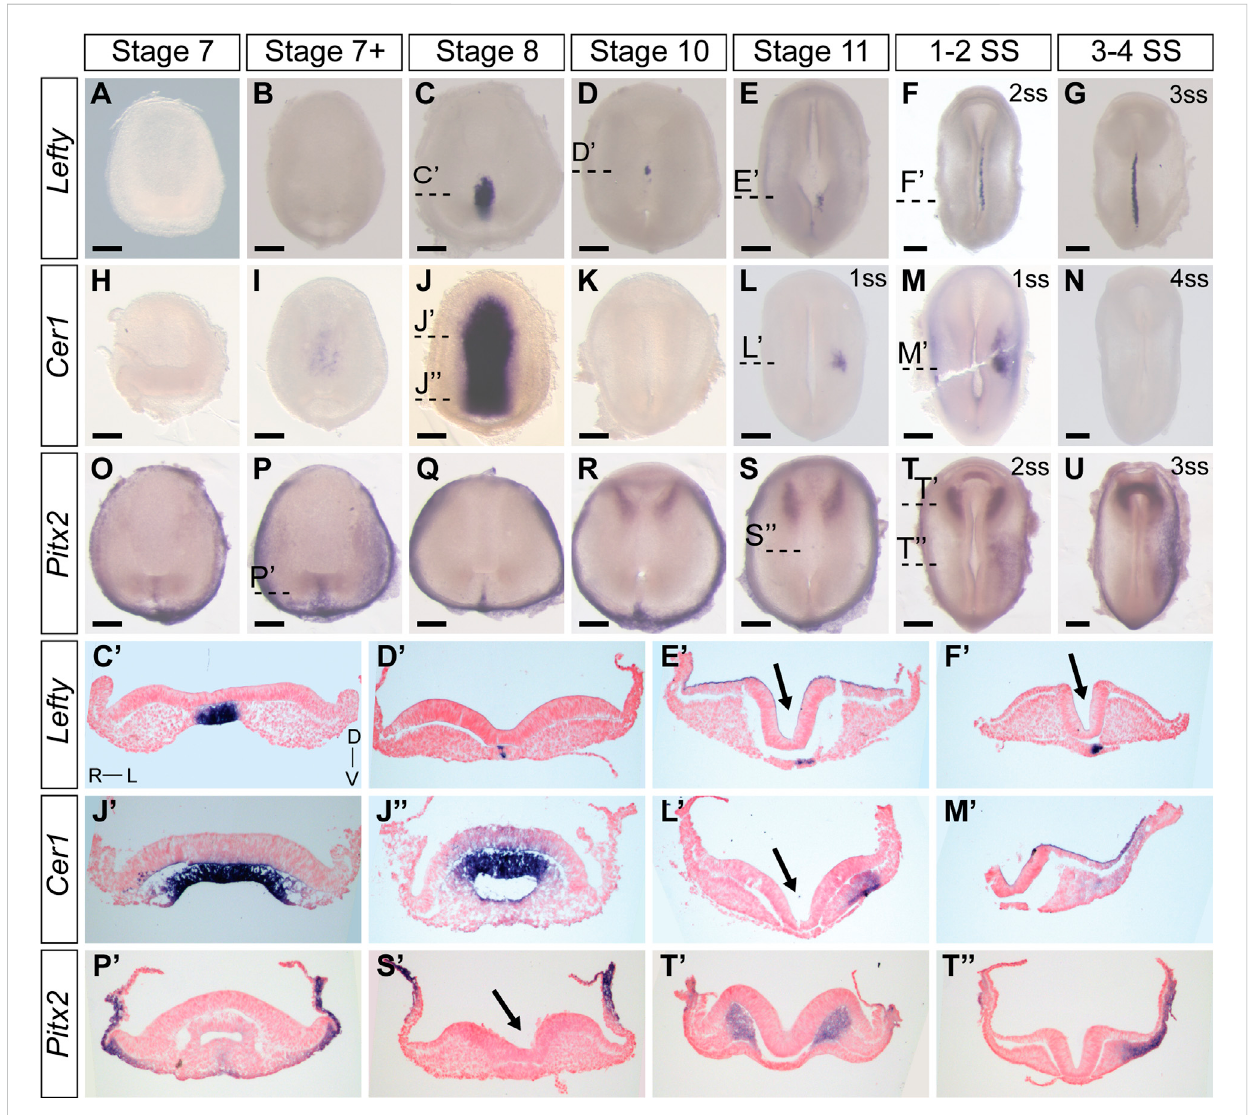
FIGURE 3 Expression patters of key members of the Nodal cascade in veiled chameleon embryos. All embryos are presented in ventral view, unless otherwise noted. Dorsal view available in Supplementary Figure S4. (A – G) Whole mount RNA in situ hybridization for Lefty expression. (H – N) Whole mount RNA in situ hybridization for Cer1 expression (O – U) . Whole mount RNA in situ hybridization for Pitx2 expression. (C 9 , D 9 , E 9 , F 9 , J 9 , J 99 , I 9 , M 9 , P 9 , S 9 , T 9 , T 99 ) Transverse sections of embryos from (A – U), as indicated with dashed lines. Sections were counterstained with nuclear fast red for better visualization. Section orientation is as indicated in (C 9 ) . Arrows point to the medial hinge point of the neural tube. All scale bars are 200 μ